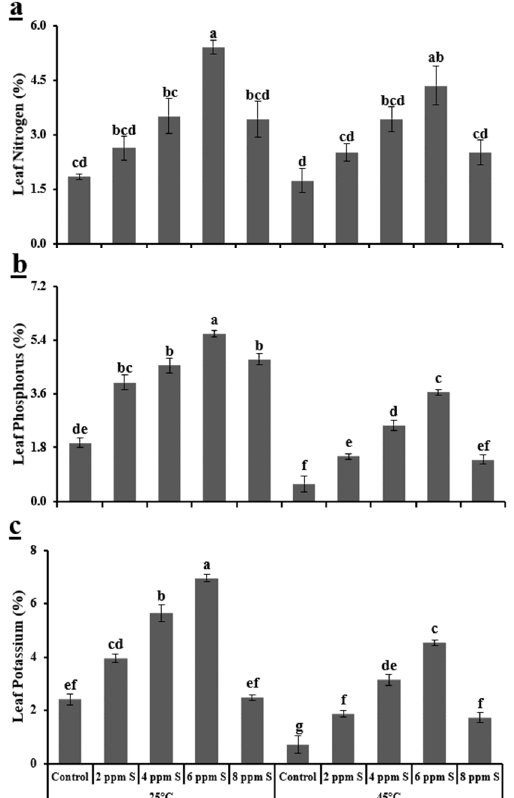
Figure 8. Leaf mineral concentrations [i.e., Nitrogen ( a ), Phosphorus ( b ), Potassium ( c )] of tomato plants (cv. Ahmar) as affected by temperature, genotype, and exogenous application of sulfur. Same letters indicate non-significant differences among treatments according to Tukey’s honestly significant difference test ( p ≤ 0.05). Vertical bars indicate averages ± standard errors ( n = 4, 5 plants per replicate).